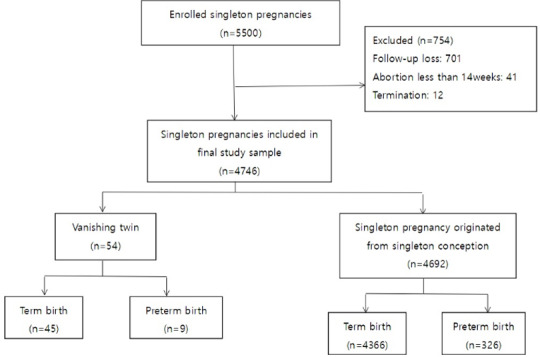
Study population.